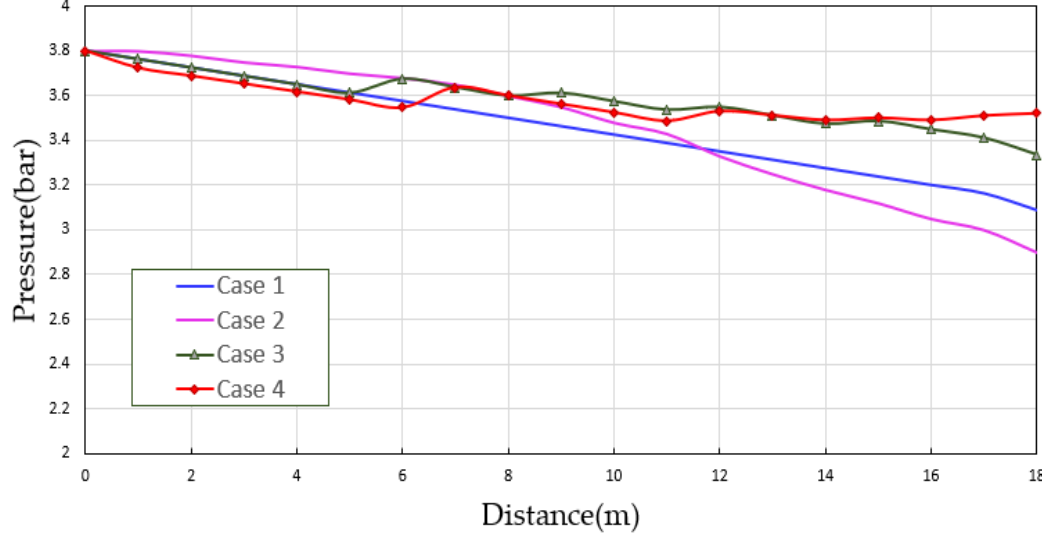
Figure 14. Vertical pressure loss simulation of BTS for different cases.